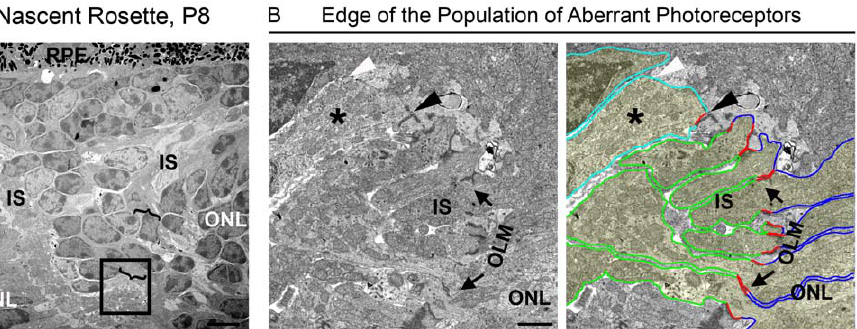
Figure 9. OLM Ultrastructure at the base of nascent rosettes. A . Ultrastructure of the nascent rosette from Figure 5D is presented here to orient the reader. B . Shown is magnified area from box. The first aberrant photoreceptor at the edge of the nascent rosette (asterisks) can be seen to form junctions with one neighboring cell (black arrowhead) yet fails to form junctions with other neighboring cells (white arrowhead). Dark blue: ONL cell bodies; red: OLM; green: ONL IS; light aqua; aberrant photoreceptors. Scale bar, A 4 m m B 1 m m.